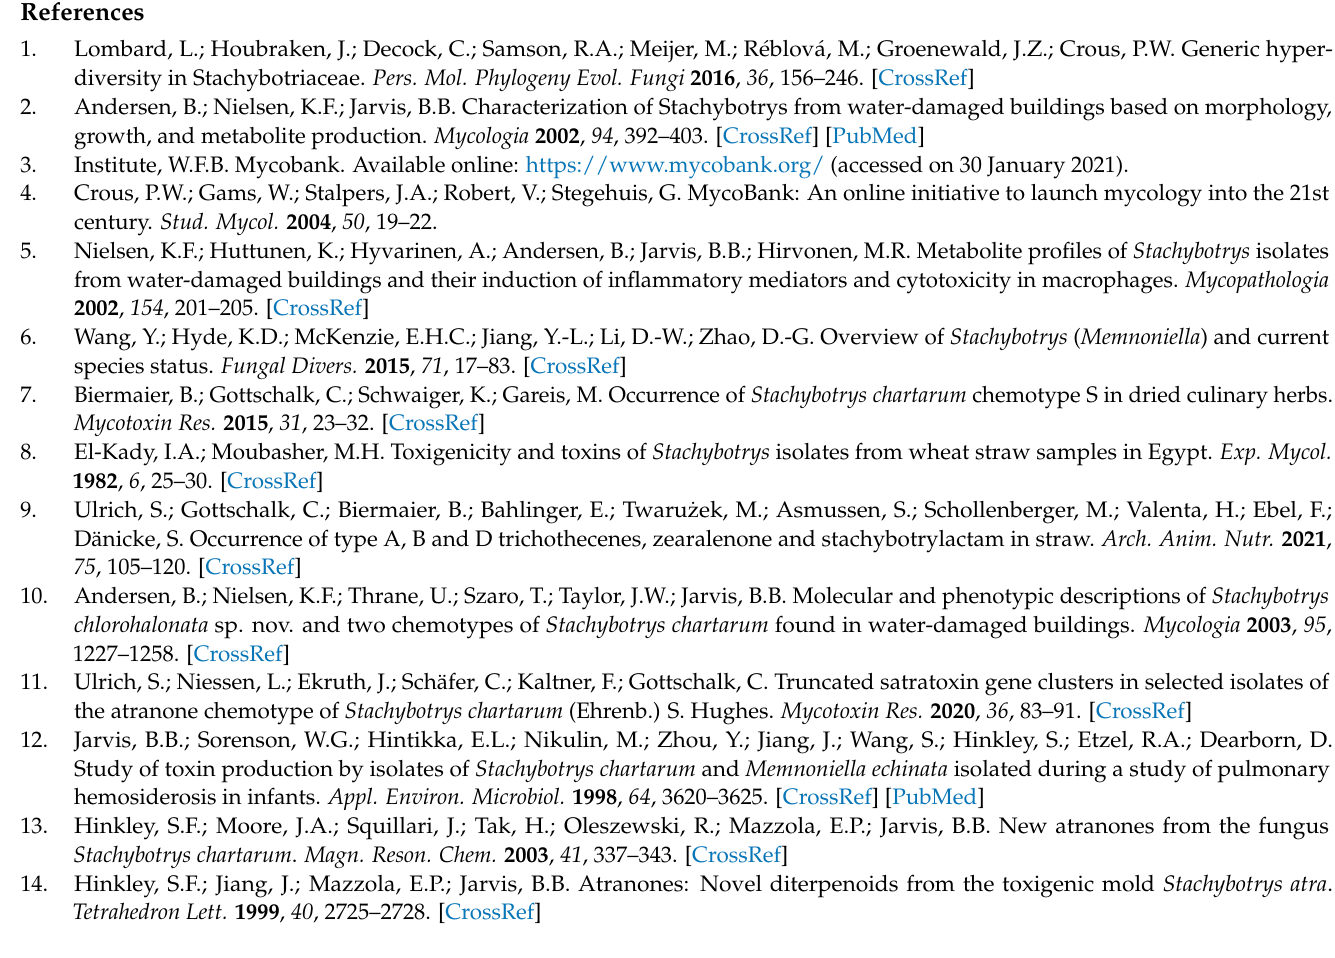
Figure S5: Sequence connecting scaffold 1 (accession KL652499) and 1543 (accession KL651645)